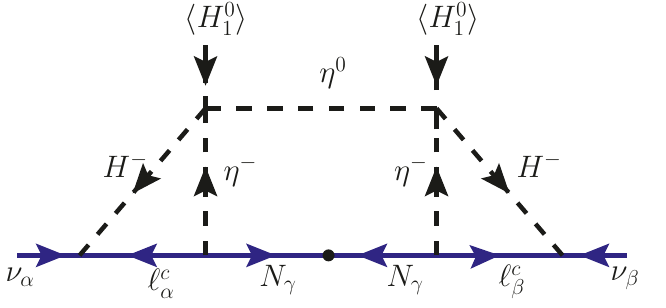
Figure 52 . Three-loop neutrino mass generation in the KNT model [36]. The model induces operator of eq. (1.4). O 9